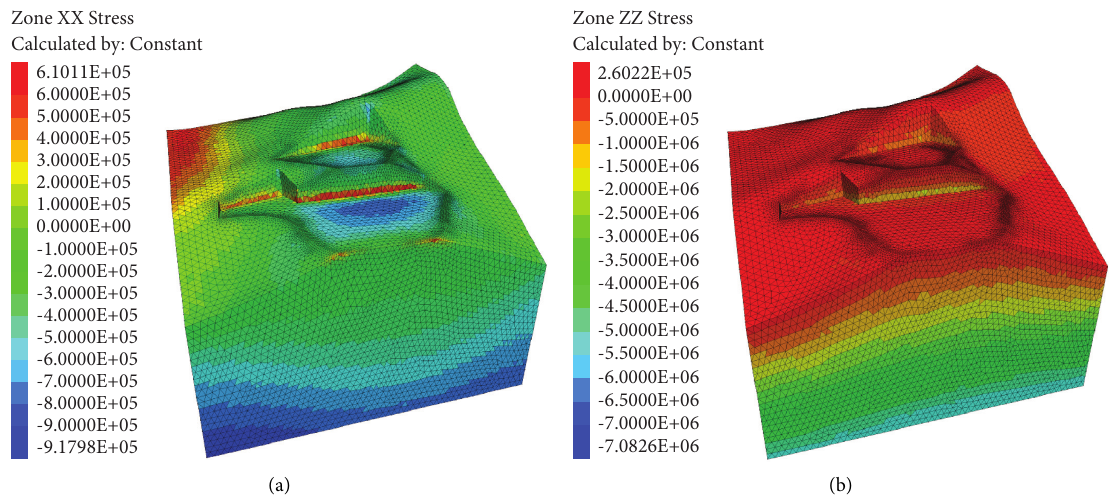
Figure 11: Stress nephogram after third excavation. (a) X -direction stress nephogram and (b) Z -direction stress nephogram.